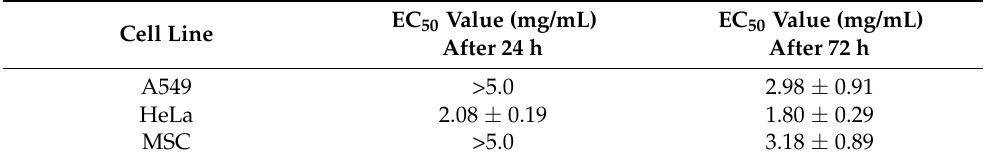
Table 1. Half-maximal effective concentration of N-CQDs for tested cell lines after 24 and 72 h in